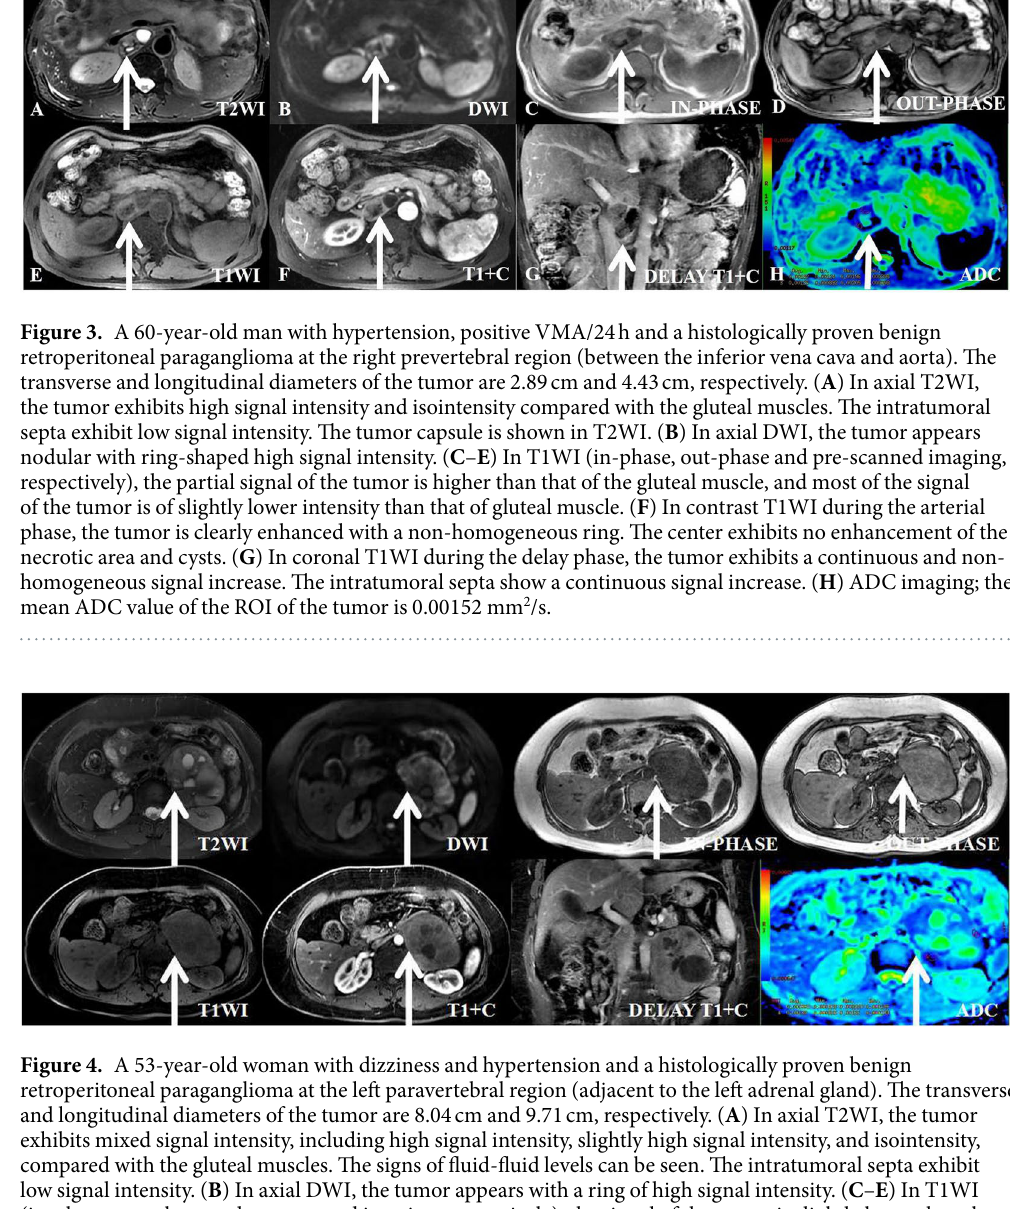
(4) The intratumoral septa, which were uneven in thickness, were shown in T2WI with low or equal signal intensity and in non-enhanced T1WI with slightly low signal intensity (n = 15); the septa were enhanced in contrast MRI. (5) The tumor capsule was observed in 15 cases in T2WI and in 10 cases in T1WI; the capsule was enhanced in contrast MRI (n = 17).